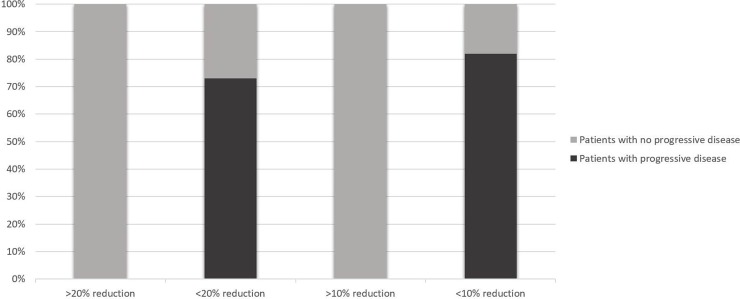
The proportion of patients who at day 30 have a > or < 20% reduction in their average biomarker level, or a > or < 10% reduction in their average biomarker level and who go on to have progressive disease (according to RECIST criteria) at day 90 (black shading) or to have no progressive disease (i.e. a complete, partial or stable response; grey shading).